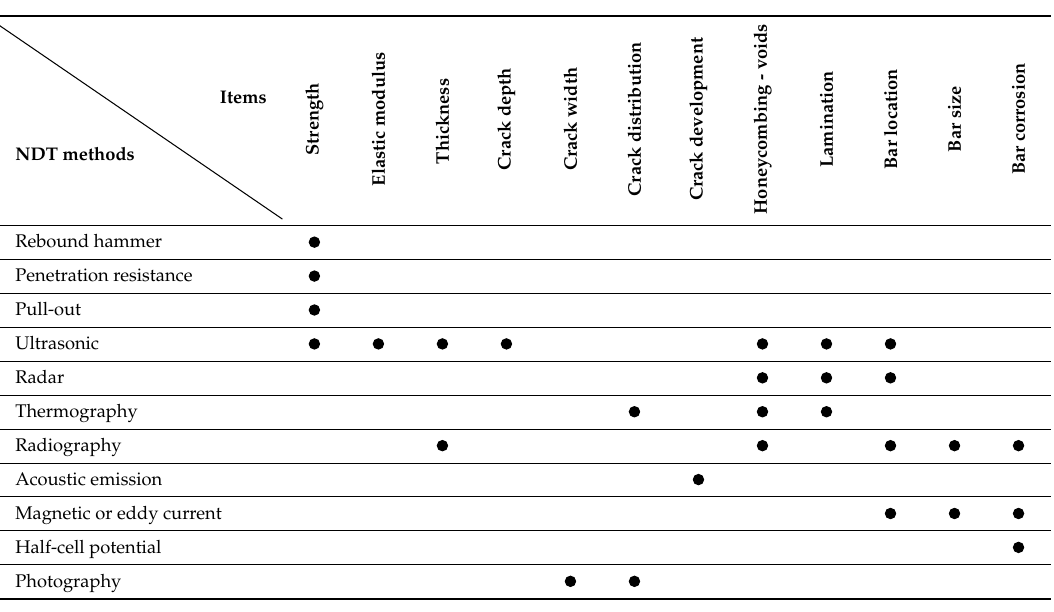
Table 1. List of items and possibilities of a nondestructive testing method usage